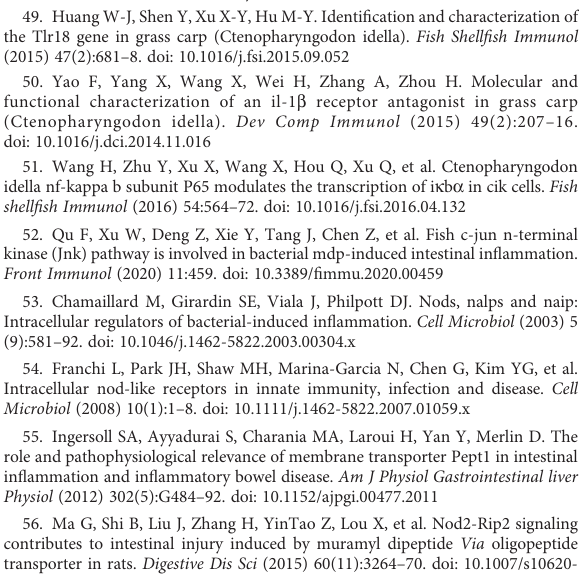
48. Magnado ́ ttir B. Innate immunity of fi sh (Overview). Fish shell fi sh Immunol (2006) 20(2):137 – 51. doi: